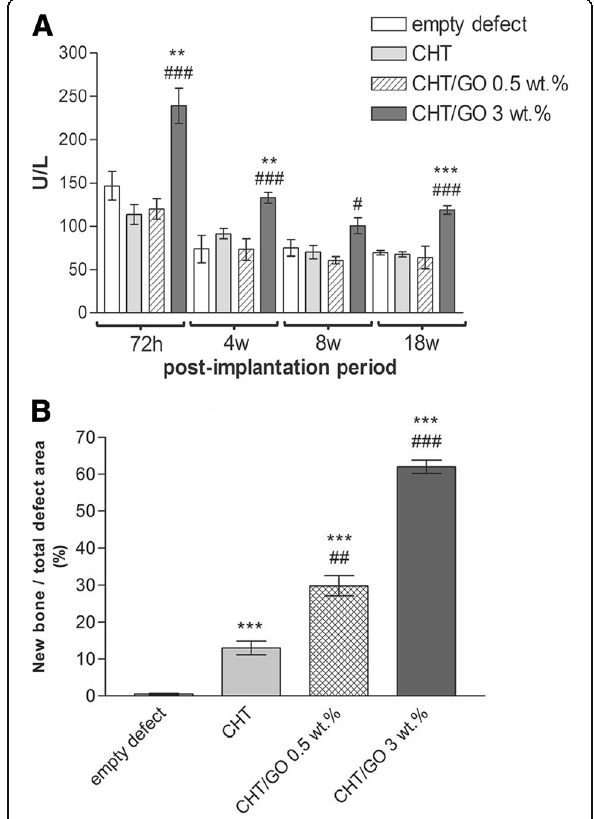
Fig. 4 a ALP activity in mice calvaria defects implanted with CHT/GO and b histomophometric analysis of Masson Goldner trichrome-stained sections. ### p <0.001 vs CHT; ** p <0.01 vs control; *** p <0.001 vs control. Reproduced from ref. [3] with permission from the Journal